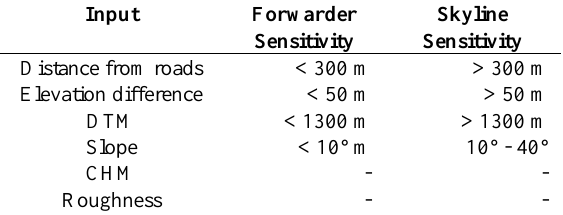
Table 6. Class sensitivity for the input layers using